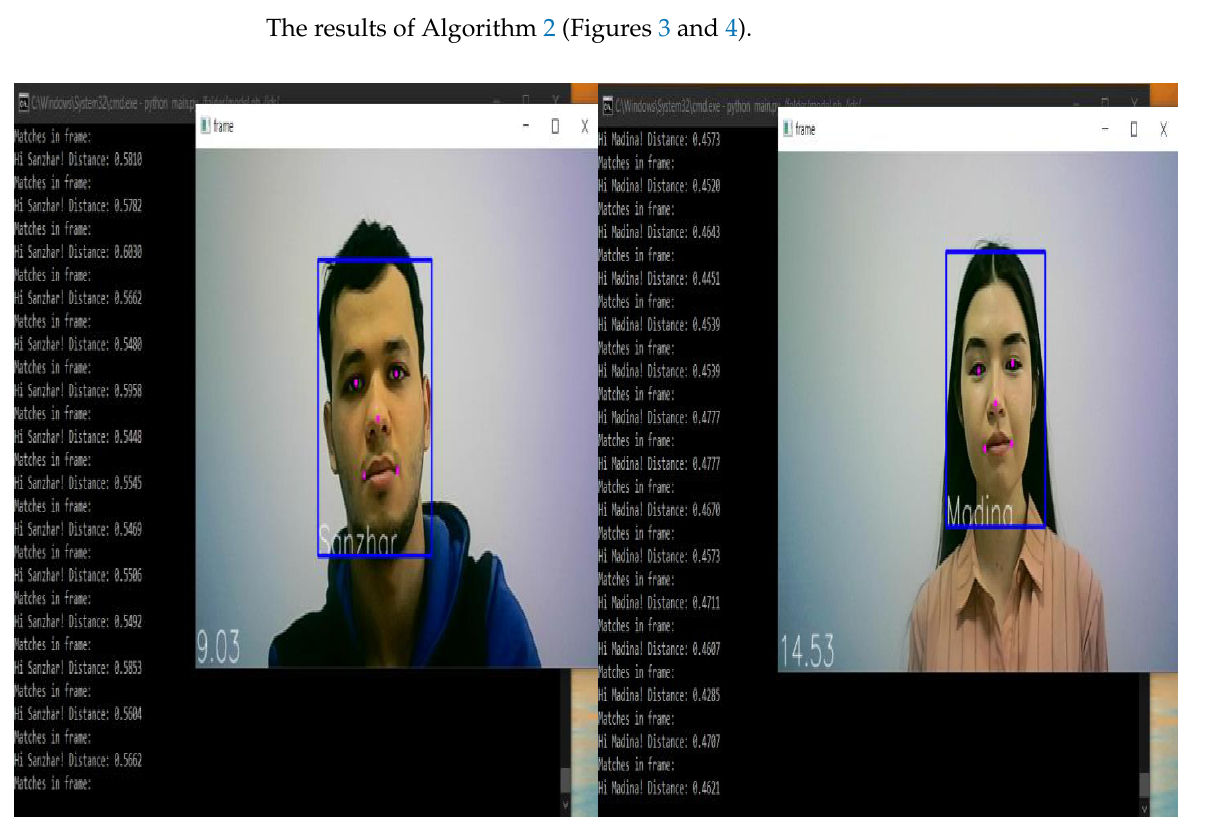
Figure 3. The result is the distance between the object and the